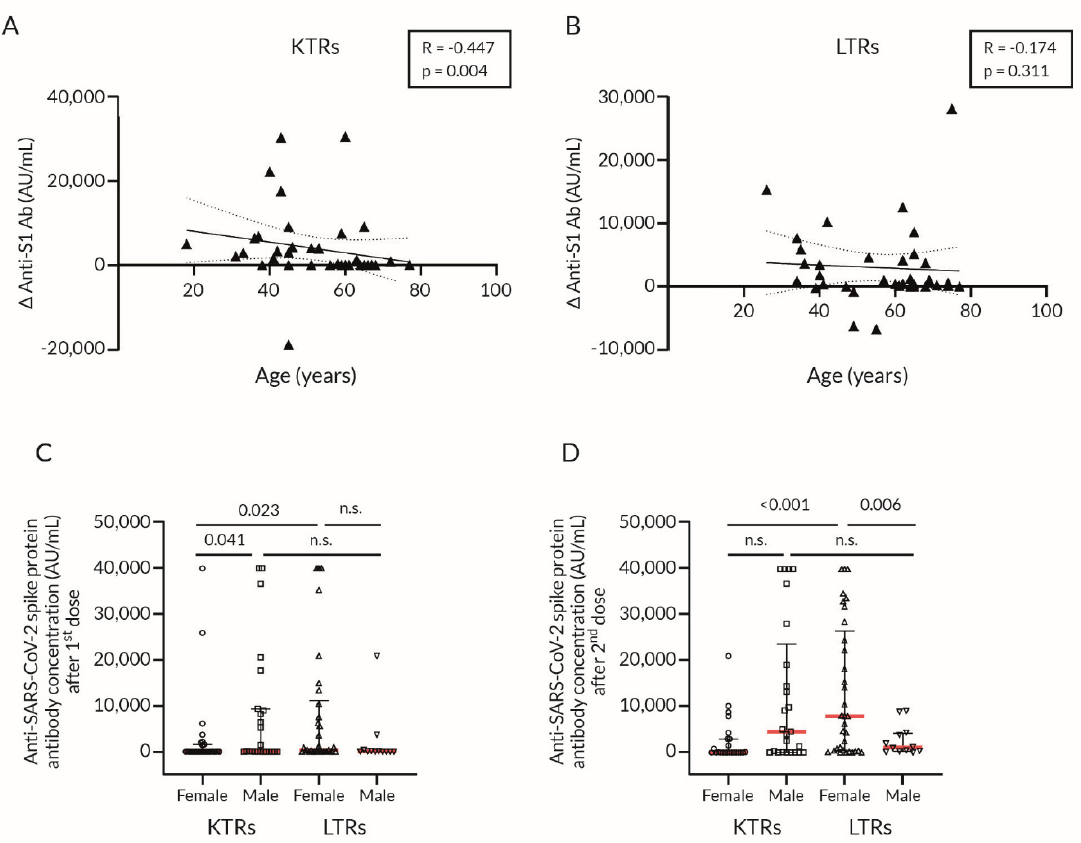
Figure 5. Immune response to BNT162b2 vaccination depending on the type of transplanted organ and age ( A , B ) or gender ( C , D ). Association of the ∆ anti-S1Ab with age in KTRs ( A ) and LTRs ( B ) was calculated with Spearman’s correlation, separate values were fitted with simple linear regression with 95% confidence interval; the scatter-dot plot ( C , D ) with median (middle line), lower (25%), and upper (75%) quartile (as whiskers), the p -value was calculated with non-parametric Mann–Whitney U Test, ∆ anti-S1 Ab—difference in anti-SARS-CoV-2 spike protein antibody concentration between 1st and 2nd dose of the vaccine; 1st dose = 4–6 weeks after the first dose of vaccination; 2nd dose = 4–8 weeks after the second dose of vaccination; BNT162b2 = BioNTech/Pfizer COVID-19 mRNA vaccine; KTRs = kidney transplant recipients; LTRs = liver transplant recipients; n.s. = not significant; R—Spearman’s coefficient. 1st dose = 4–6 weeks after the first dose; 2nd dose = 4–8 weeks after the second dose; BNT162b2 = BioNTech/Pfizer COVID-19 mRNA vaccine; F = female; M = male; n.s. = not significant. Table 4. Comparison of SARS-CoV-2 spike protein Ab concentration (AU/mL) after BNT162b2 vaccination with clinical variables.